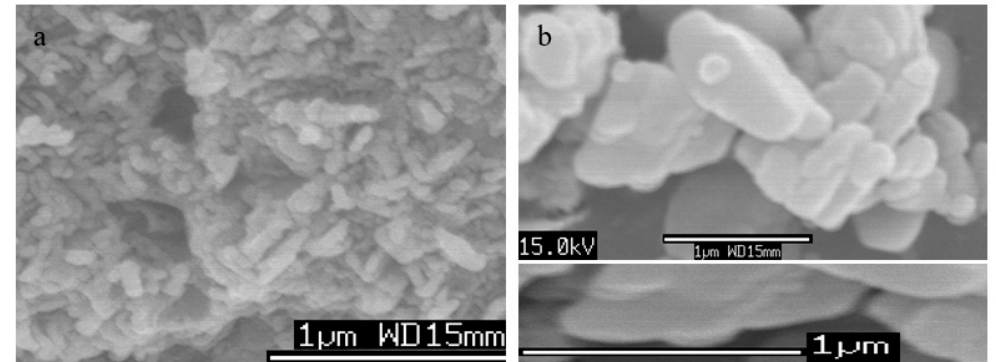
Figure 7. SEM images of Ni-Ti-4 LDHs at different magnification: ( a ) first location and ( b ) second location.